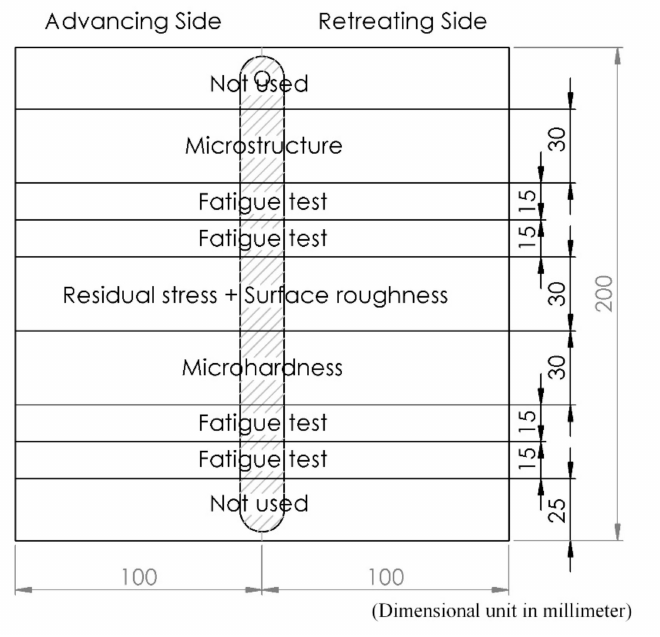
Figure 7. Each part of the